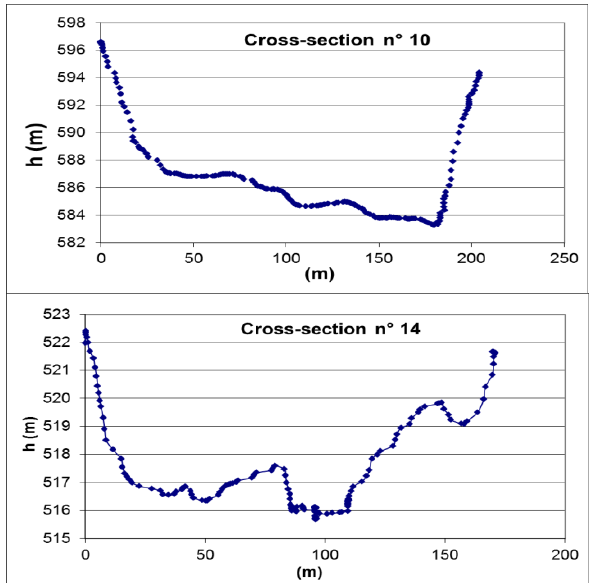
Figure 7. Two examples of river cross- sections surveyed by GNSSalong the upper part of the River Soliette